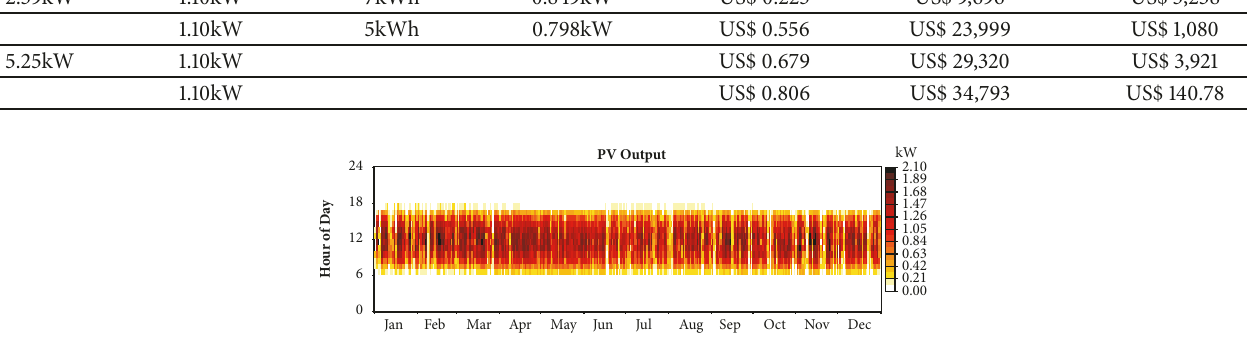
Figure 7: PV power output, 2.63kW all-PV (optimum).